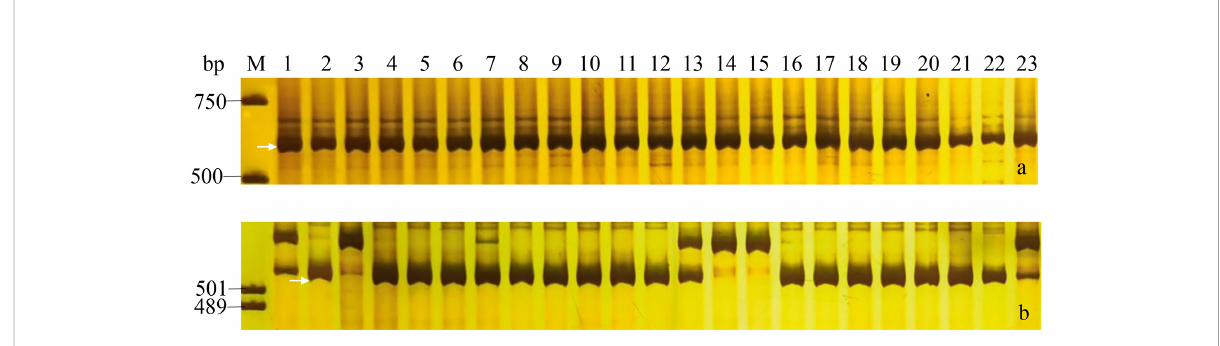
FIGURE 4 PCR ampli fi cations of speci fi c markers P22 for Dreb1 (A) and Vp1B3 for Vp-1B (B) in 23 Yannong series wheat cultivars/lines. M, DL2000 (A) / pUC19 (B) ; Lane 1-23: Yannong 30, Yannong 37, Yannong 377, Yannong 15, Yannong 17, Yannong 23, Yannong 24, Yannong 31, Yannong